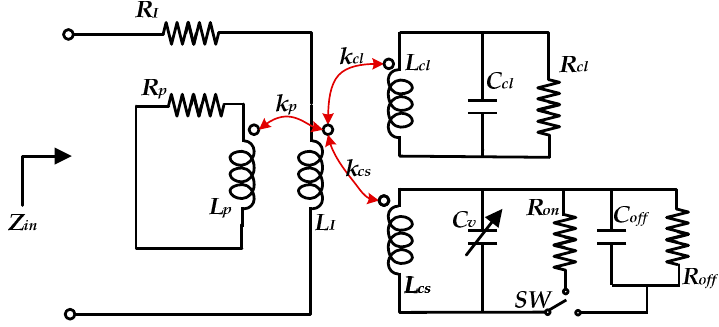
Figure 3. The equivalent circuit model of the DLNCSS inductor.